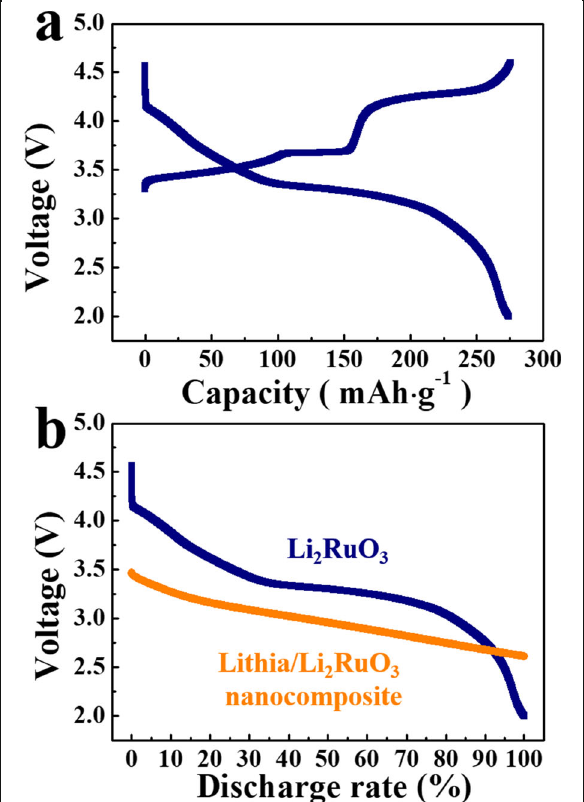
Fig. 5 a Charge-discharge profile of Li 2 RuO 3 . b Comparison of the discharge profile between lithia/Li 2 RuO 3 nanocomposite and Li 2 RuO